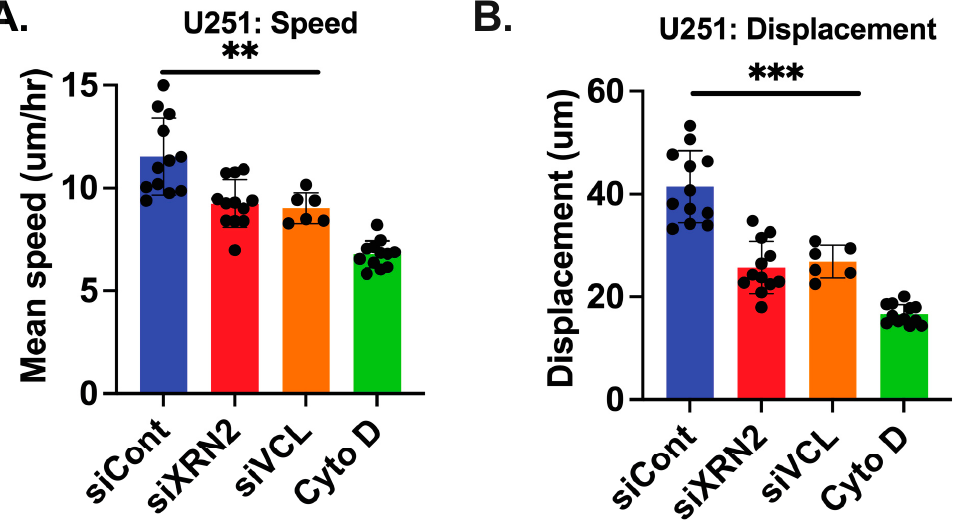
Figure 6. Loss of VCL or XRN2 results in a similar decrease in the speed or displacement in GBM cells. Quantification of U251-GFP tracking. Changes in ( A ) speed and ( B ) displacement upon control, VCL or XRN2 knockdown by siRNA are shown. ** p -value ≤ 0.01, *** p -value ≤ 0.001. The Students t -test was used for statistical analysis.